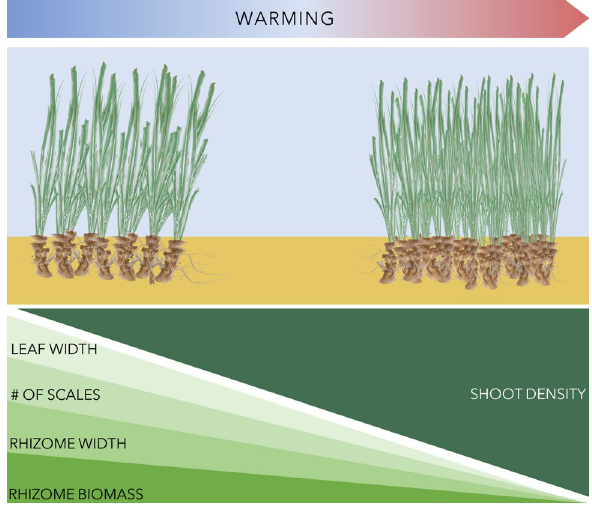
Figure 5. Summary of the results. Shoot density, morphometry and productivity was measured to examine the performance of the seagrass to the thermal gradient. Warming will trigger denser seagrass meadows with slender shoots (lower rhizome width and biomass) and fewer leaves (scales).